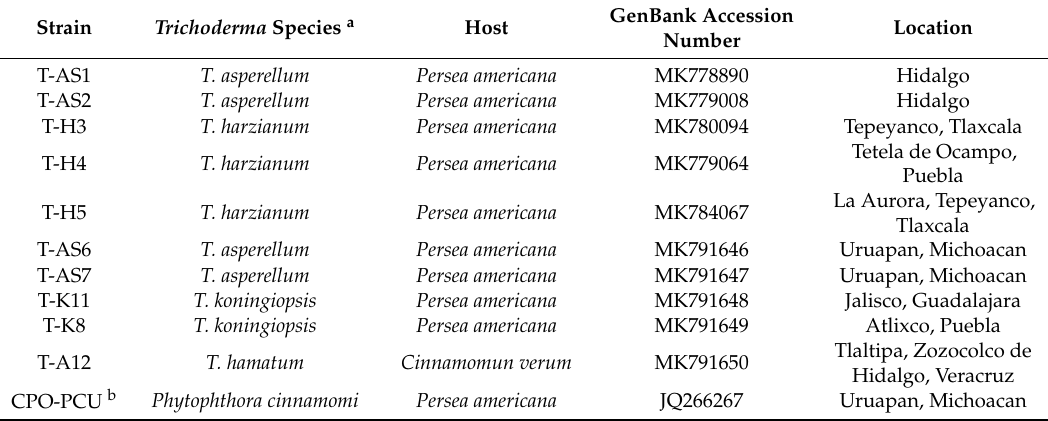
Table 1. Endophytic species of Trichoderma and Phytophthora cinnamomi isolated from avocado and cinnamon roots recovered from di ff erent states of